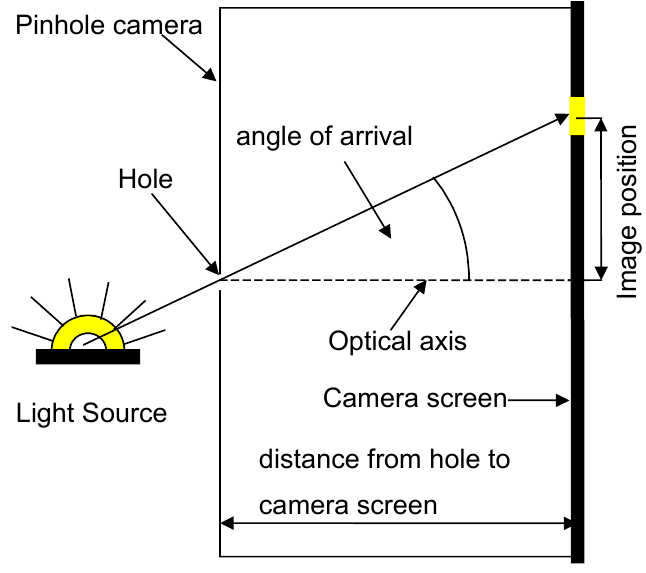
Figure 1. Angle of arrival determination with a simple pinhole camera.